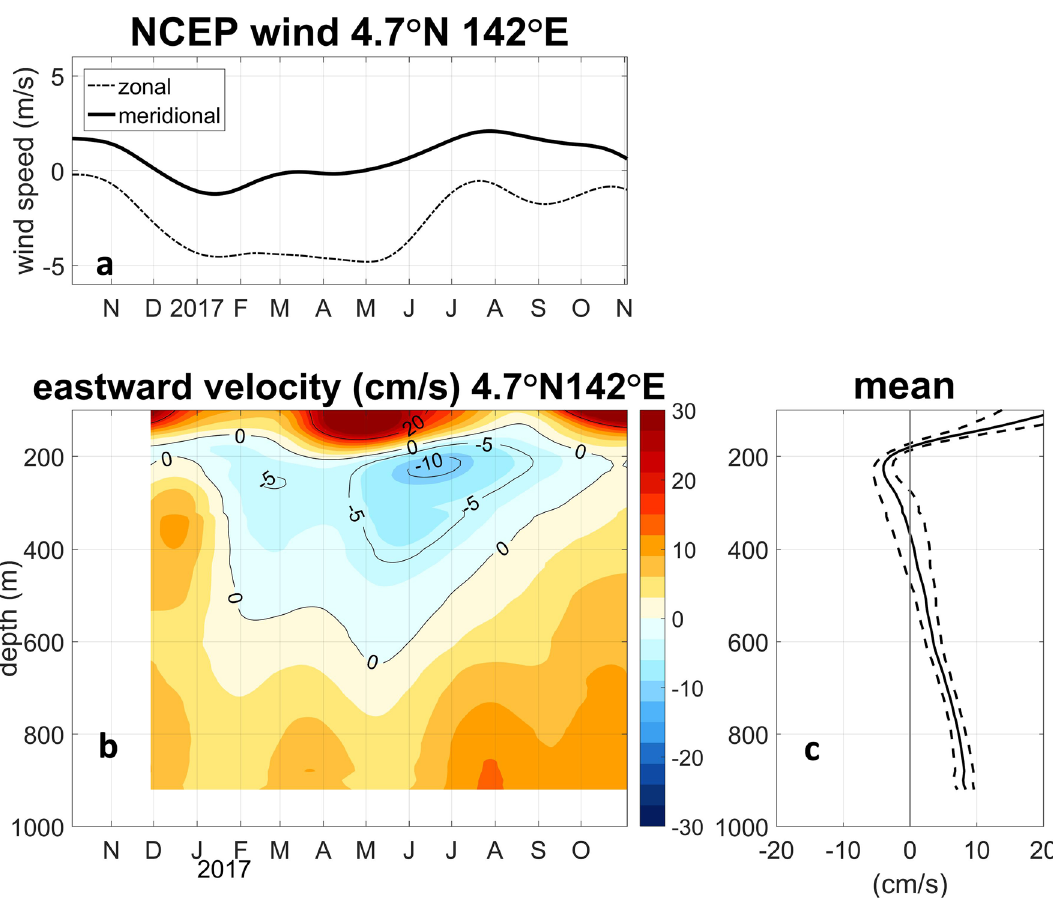
Figure 3. ( a ) Wind speed components of the NCEP/NCAR reanalysis, ( b ) zonal velocity of the moored current meter measurements, and ( c ) its mean zonal velocity profiles at 4.7° N, 142° E. Units of the wind speed and current are m s −1 and cm s −1 , respectively. Positive values represent the northward component of the wind velocity and the eastward component of the current velocity. Dashed lines in ( c ) indicate the standard errors of the means at a 95% significance level. The figure is generented by MATLAB software version R2019b (https :// www.mathw